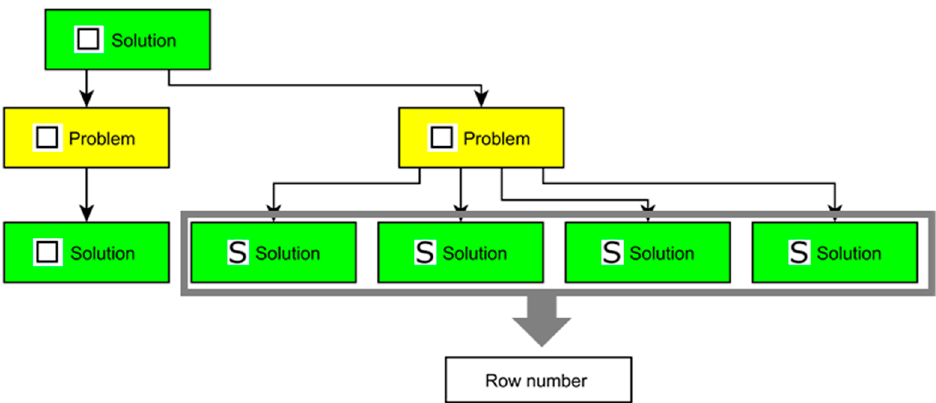
Figure 3. The white box collects all the alternative solutions at the structural level. It indicates the row number of the chart (see Figure 4) where the images of the generalized CAD models of each solution are reported.